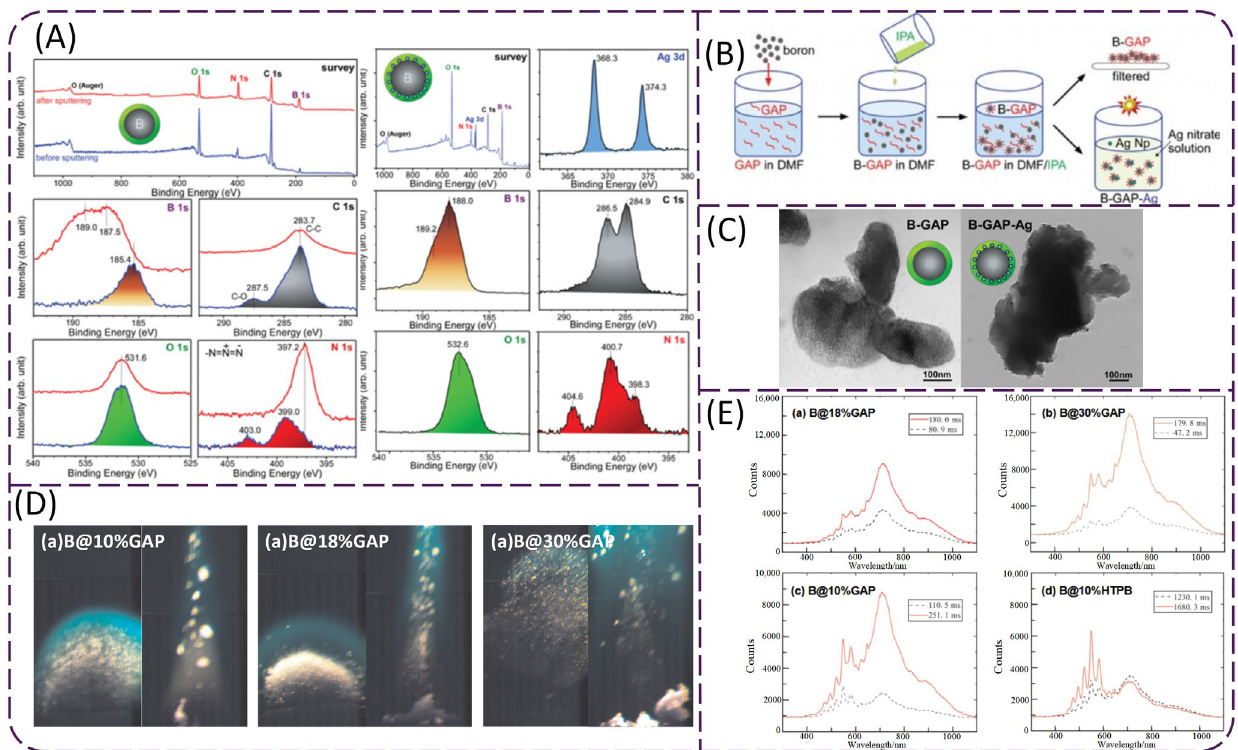
Figure 8. ( A ) Survey and high - resolution (B 1s, C 1s, O 1s, and N 1s) XPS spectra of B@GAP